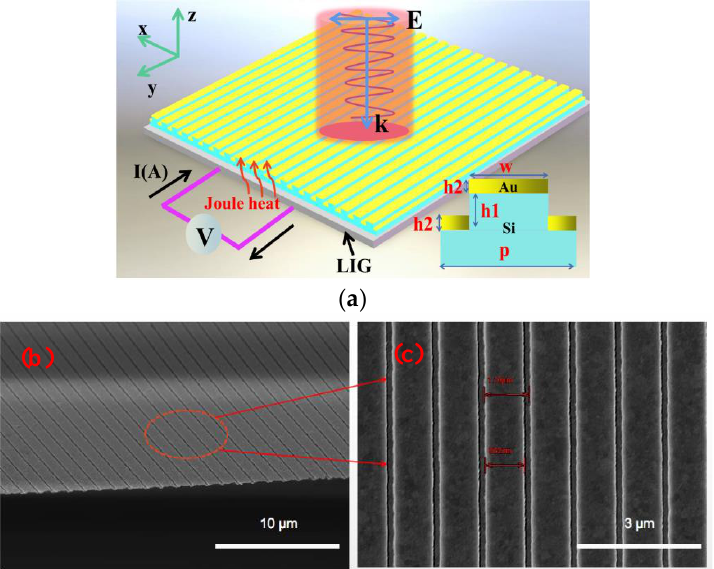
Figure 1. Design and fabrication of the structure ( a ); schematic diagram of device structure ( b ); oblique view of the scanning electron microscope ( c ); partial magnification of top view of the scanning electron microscope.